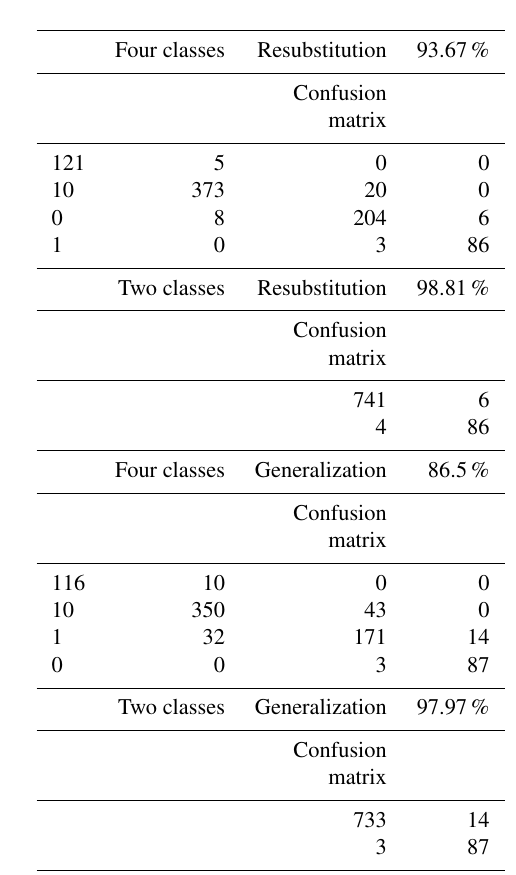
Table 1. Classification results for BME680 data using the hold-out approach for the 8 July to 19 September campaign with kNN ( k =